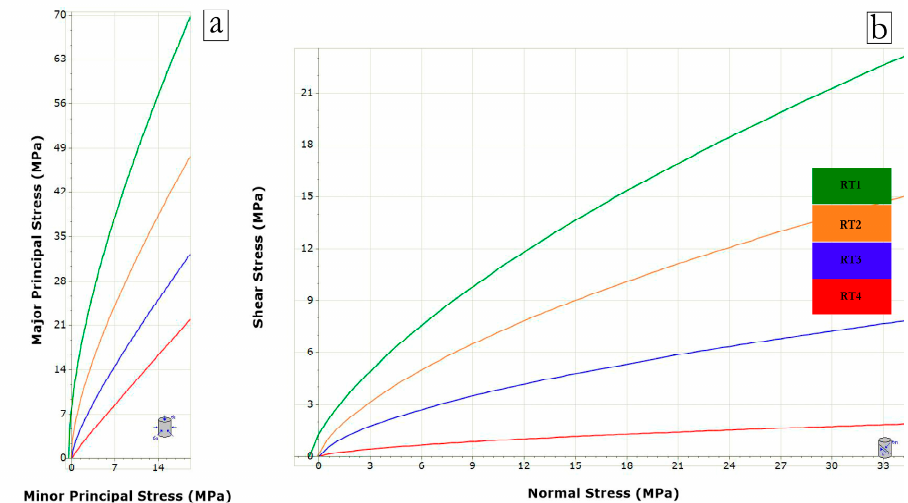
Figure 7. Principal stress plot ( a ) and Normal vs. Shear stress plot ( b ) for the four litho-technical units, after the Hoek-Brown criterion.